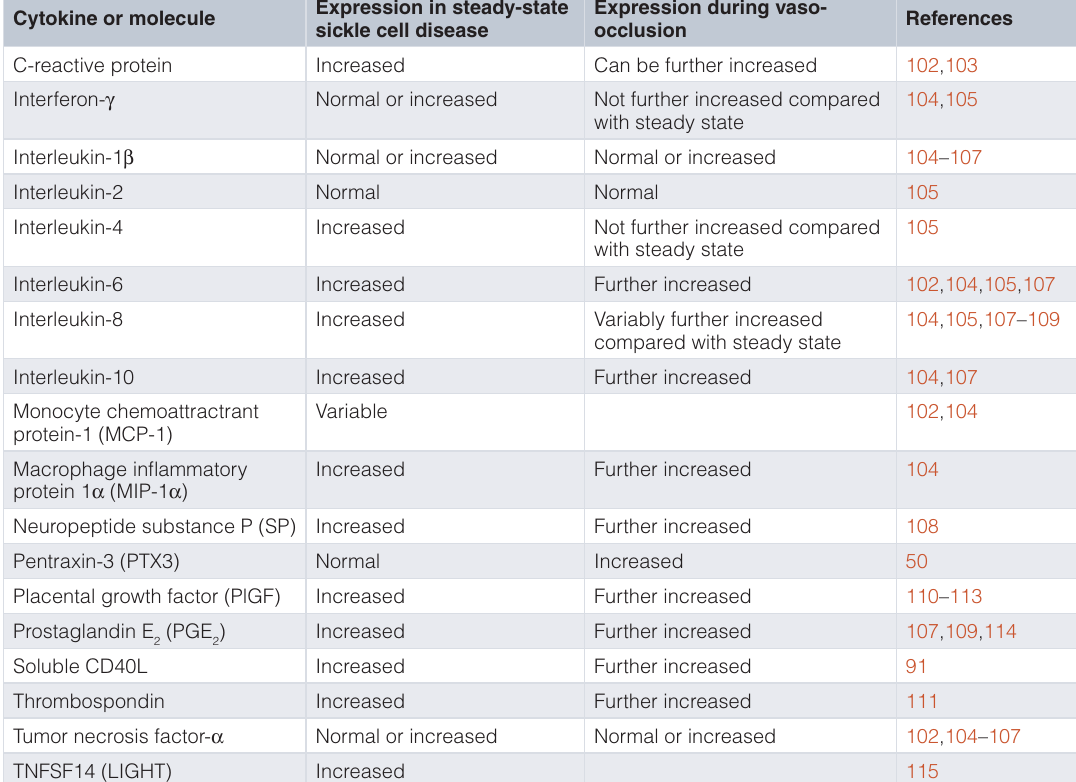
Table 1. Expression of cytokines, acute-phase proteins, and inflammatory molecules in sickle cell disease. Cytokine or